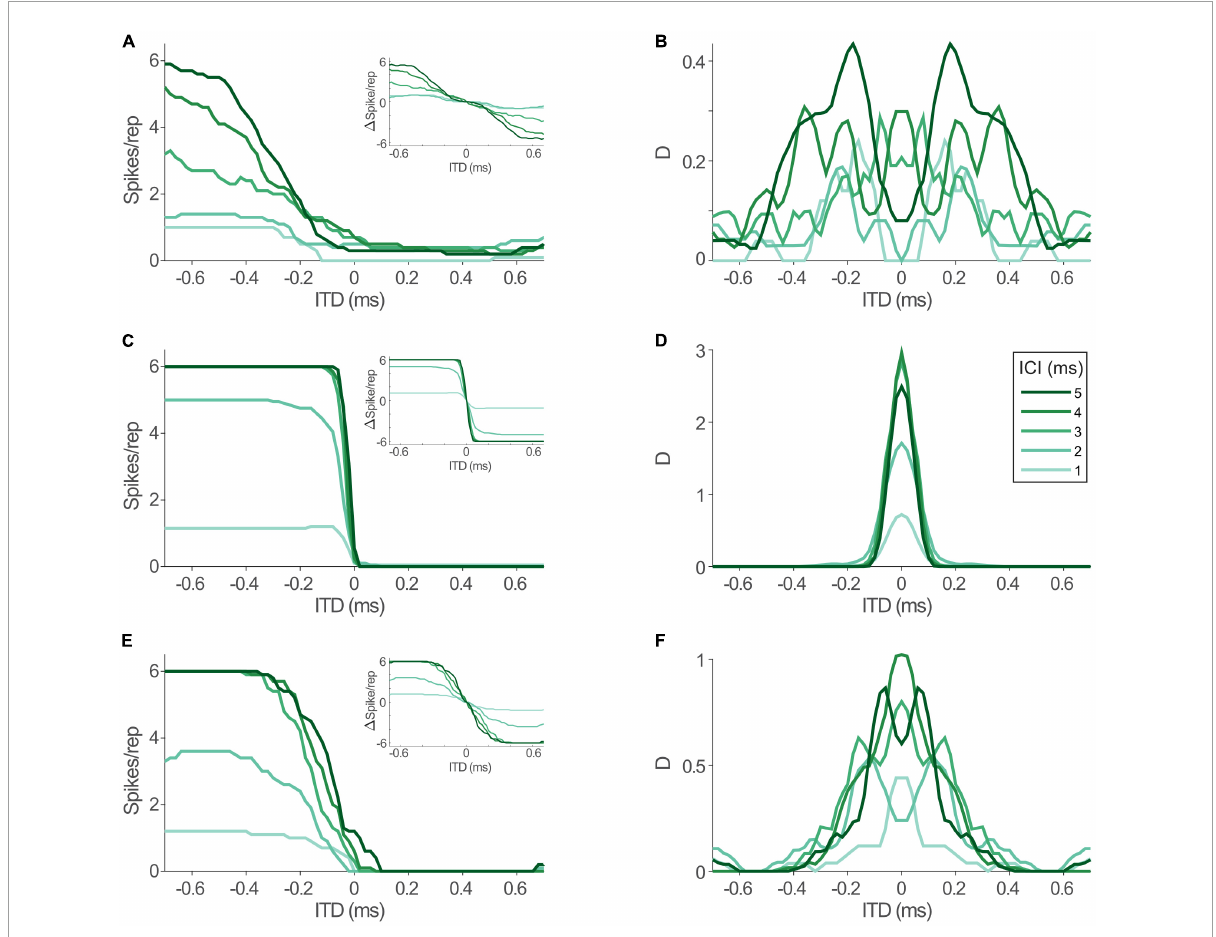
FIGURE5 Interaural time differences (ITD) sensitivity in model lateral superior olive (LSO) is maintained during electrical stimulation, but altered by jitter level. (A) Model rate-ITD functions during acoustic stimulation. Inset shows hemispheric rate differences for all inter-click intervals (ICIs) (assuming mirrored rate-ITD functions in the LSO on the other brain hemisphere). (B) Standard separability D of the hemispheric rate differences for the data shown in panel (A) . (C,D) Same as in panels (A,B) , but for electric stimulation. (E,F) Same as in panels (A,B) , but for electric stimulation with jitter levels of the model inputs increased to resemble acoustic